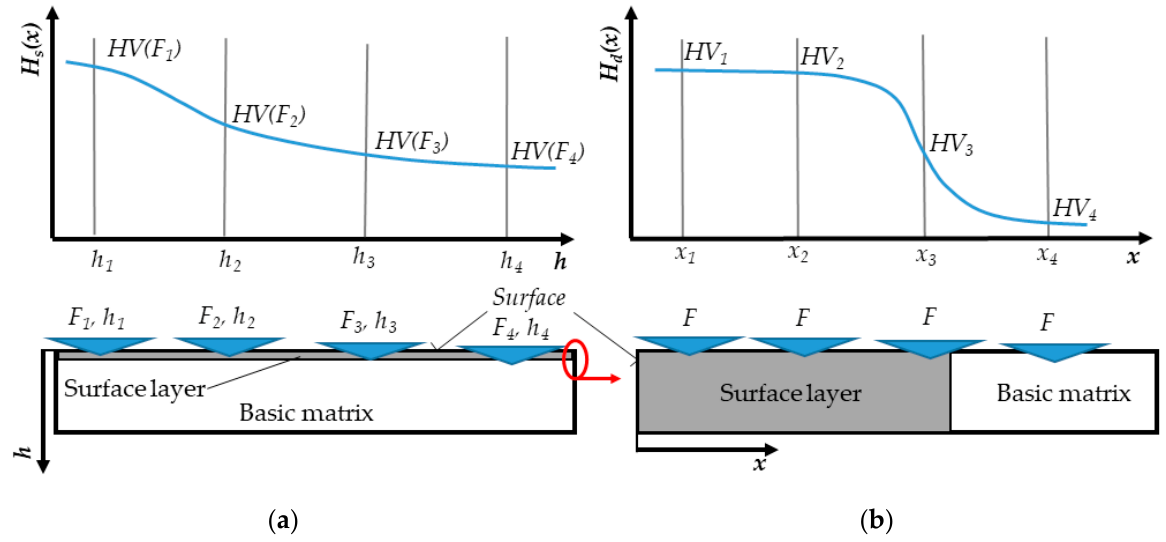
Figure 1. Interpretation of the H s surface and the H d in-depth hardness function. ( a ) Surface; ( b ) in- depth.